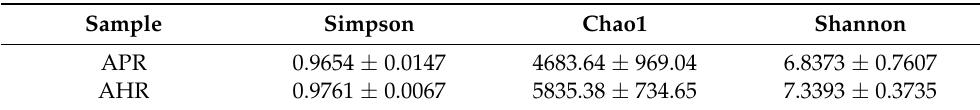
Table 2. α diversity index of gut microbes in captive giant pandas adopting different nursing methods.